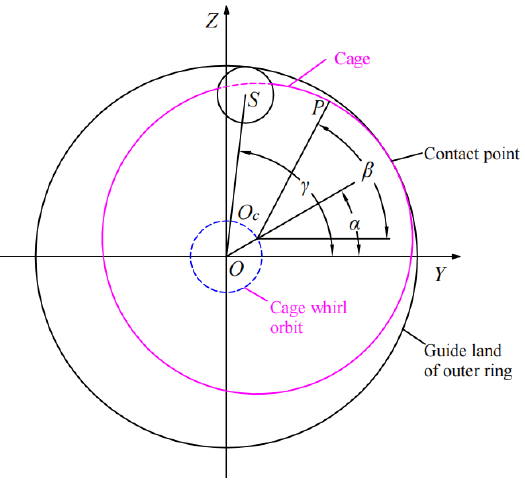
Figure 1. Schematic diagram of cage whirl.